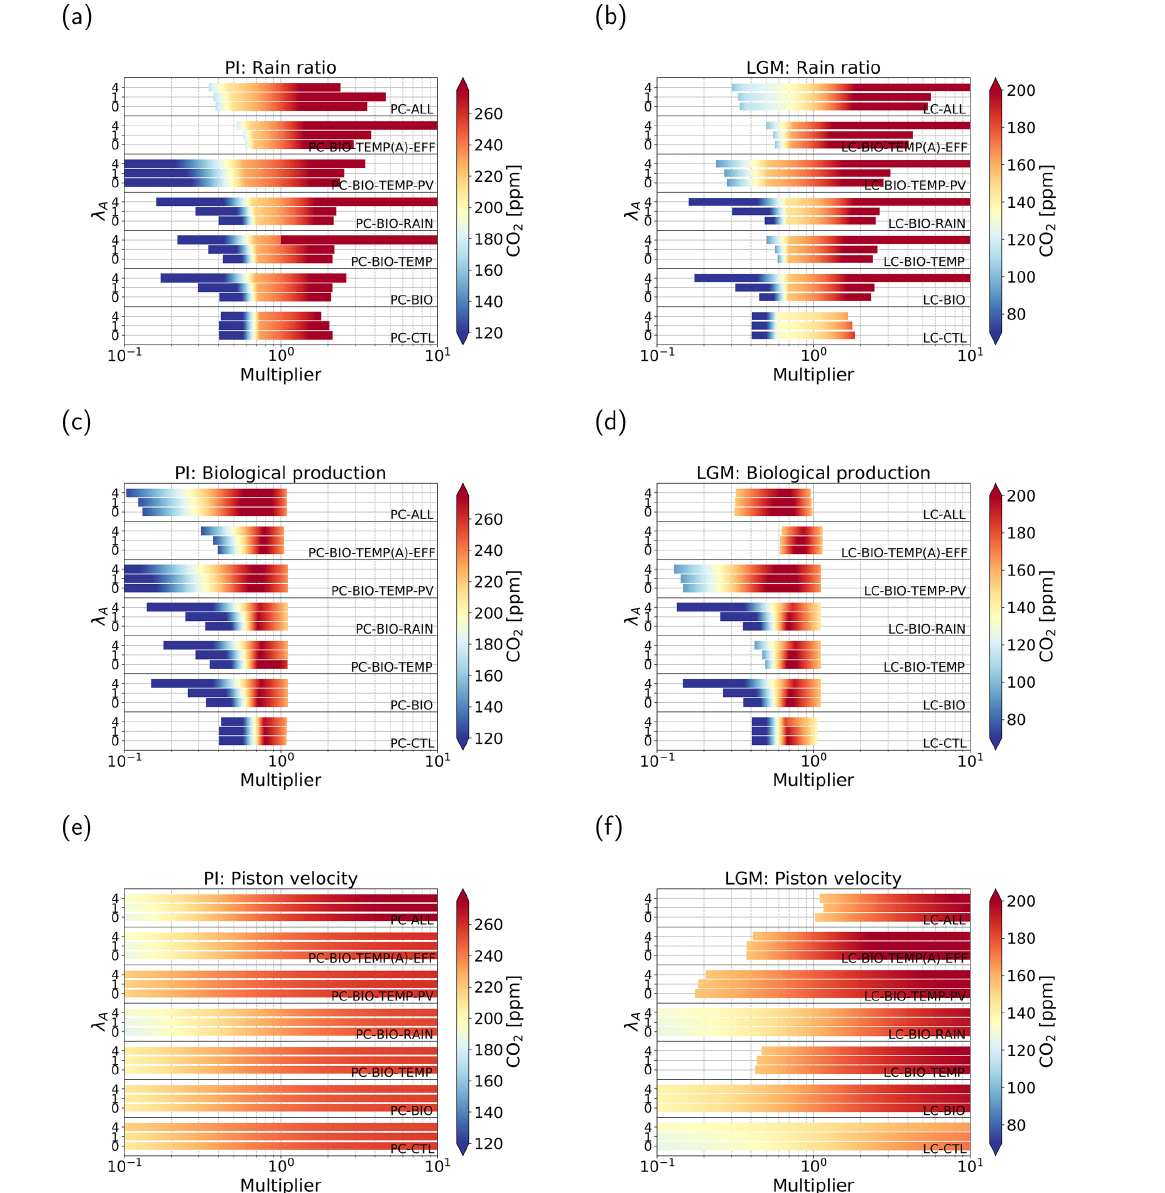
Figure 4. Atmospheric p CO 2 in parts per million (color shading) under varying parameter values. Panels (a, c, e) represent cases of the PI configuration and (b, d, f) of the LGM configuration. Panels (a, b) show cases where the strength of the rain ratio is varied between 0.1 and 10 times the original value. Panels (c) – (f) show the same but for cases where biological production (c, d) and the piston velocity (e, f) are varied. In total seven feedback combinations are used, denoted by the text within the graph. For each case, three different coupling strengths have been used: (1) λ A = 0, (2) λ A = 1, and (3) λ A =